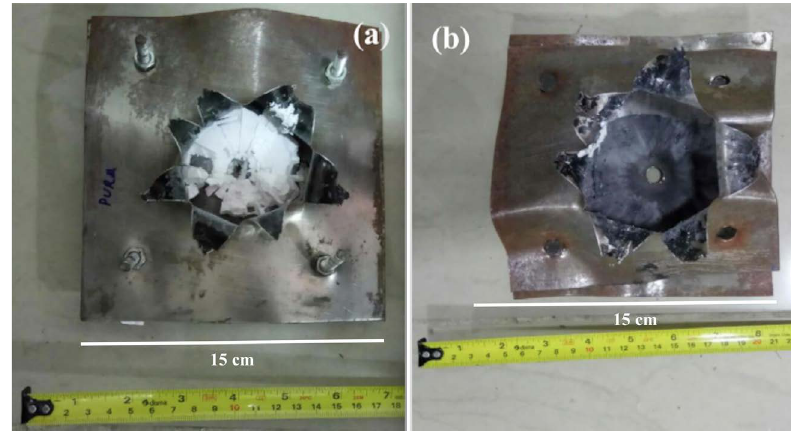
Figure 4. Samples of (a) pure alumina and (b) niobo-phosphate glass-doped alumina after ballistic Table 3. Results of residual velocity and absorbed energy from the ballistic tests. Samples